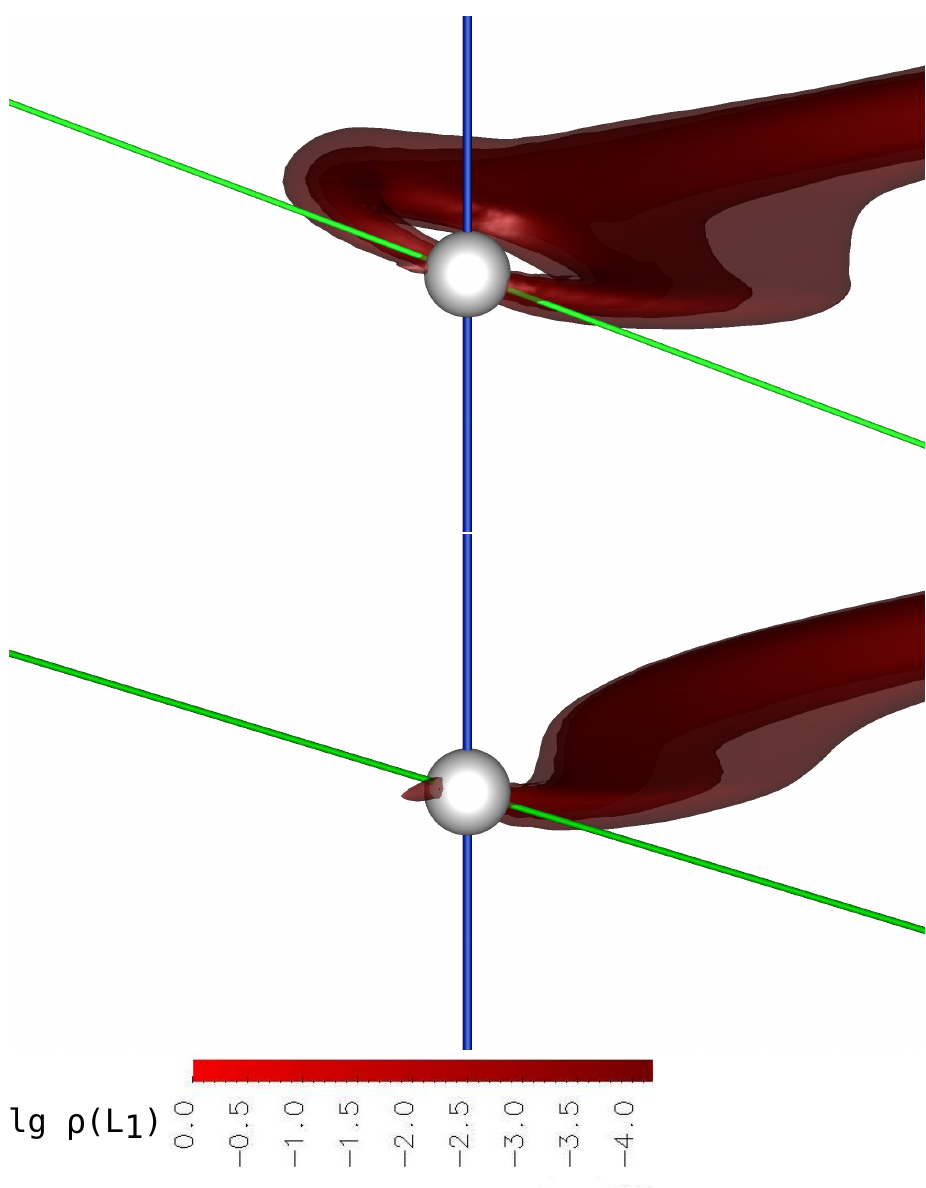
Figure 9. The same as in Figure 8, but for Phase 3 ( upper panel)) and Phase 4 ( lower panel). Table 3. Parameters of accretion of matter on a white dwarf in the asynchronous polar with non-offset dipole for different phases of switching the flow from the south pole to the north